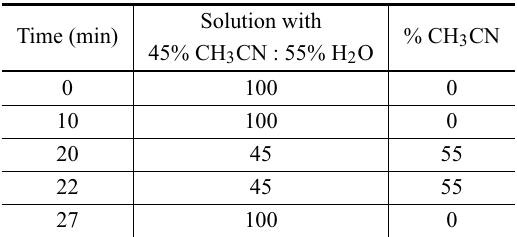
RP-HPLC solvent gradient varying the mobile phase water-acetonitrile composition used in the bromophenols